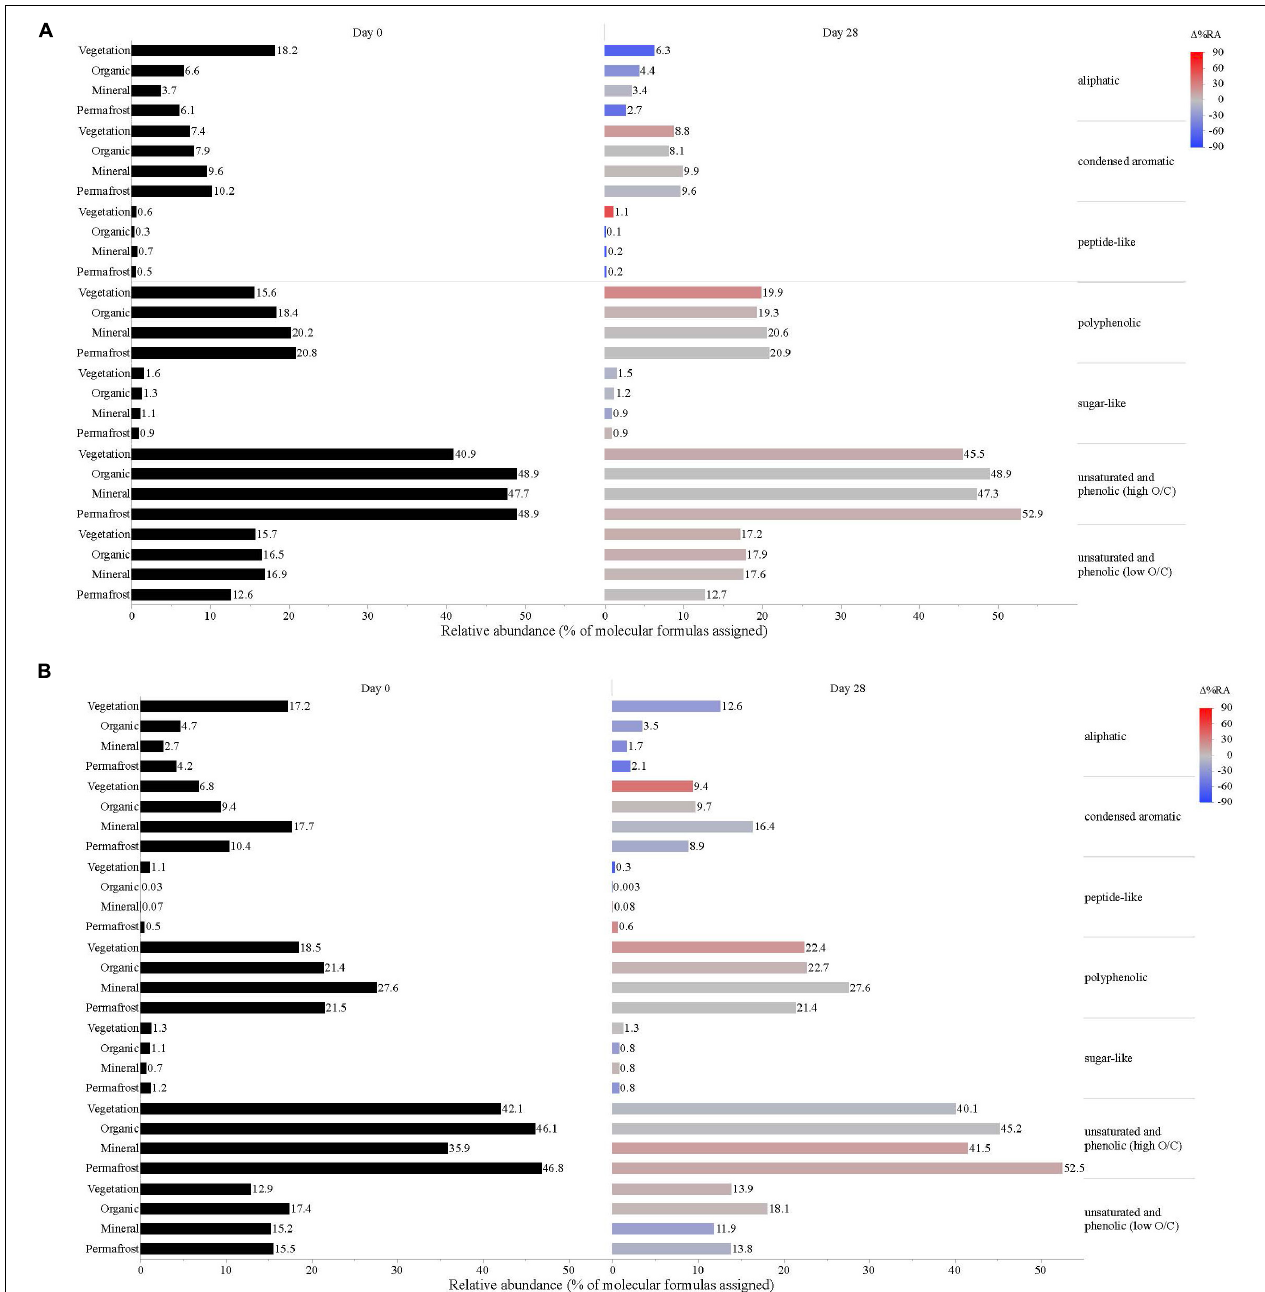
FIGURE 5 | Leachate DOM composition at (A) Erickson TK and (B) Old Man site by compound class and layer. Bars indicate the relative abundance of different compound classes, with black bars showing the relative abundance at t = 0 and colored bars representing the relative abundance by t = 28. The color scale reflects the percent change in relative abundance of each DOM compound class over the bioincubations, with red bars indicating a relative increase in abundance and blue bars indicating a relative